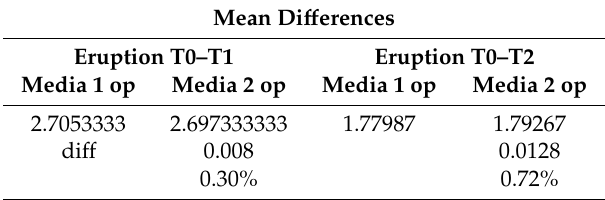
Table 11. Mean Di ff erences between eruption to two (T0–T1) and four months (T0–T2).